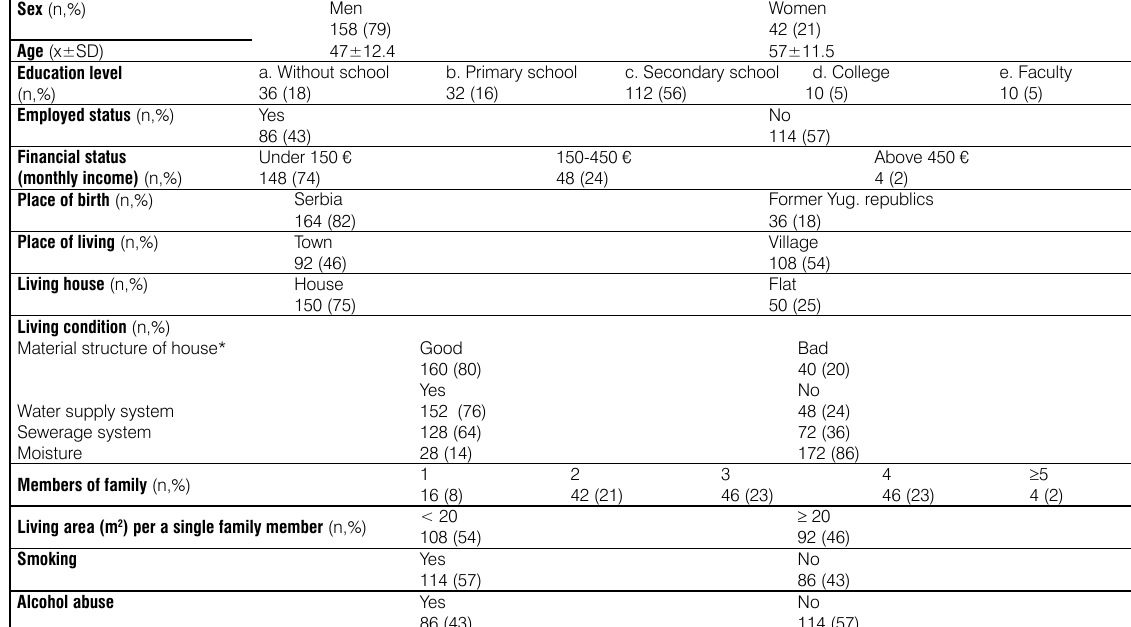
Table 2. Answers to the questionnaire no. 2 (n,